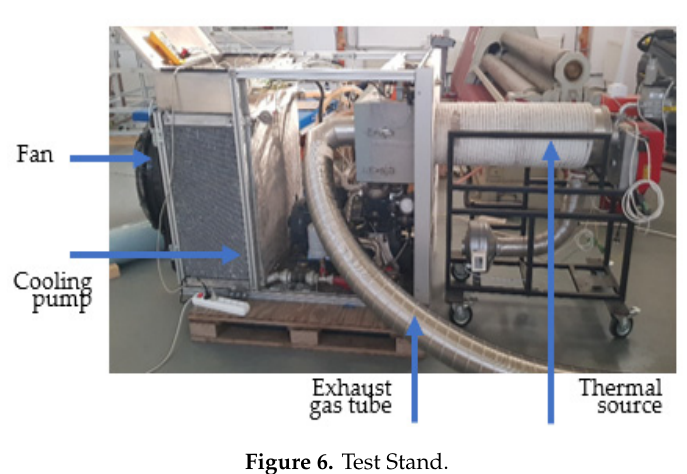
Figure 6. Test Stand. Figure 6. Test